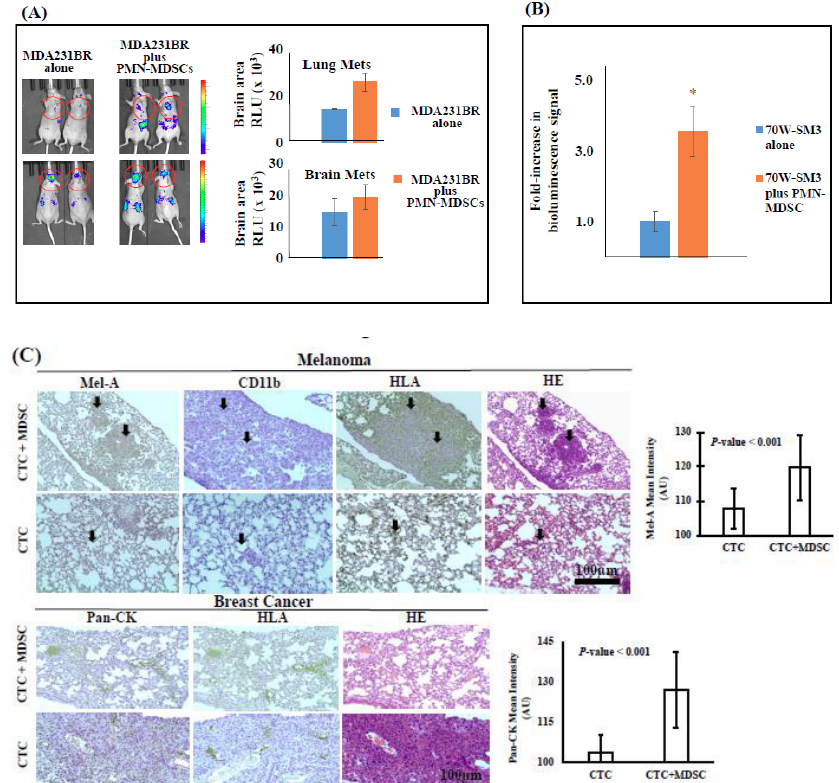
Figure 4. The detection of bioluminescence signal following the injection of human brain-metastatic breast cancer (MDA-MB-231BR) ( A ) (red circles refer to the detection of brain metastasis in mice) or melanoma (70W-SM3) mice ( B ) cells with or without co-transplantation with circulatory PMN-MDSCs isolated from blood of respective patients. Representative animals are shown ( n = 3/subgroup; * p < 0.001). ( C ) CTC metastatic competence is increased by PMN-MDSCs. Patient-isolated CTCs were injected together with PMN-MDSCs derived from respective breast cancer or melanoma patient blood via intra-cardiac route. Following animal euthanization and tissue organ processing, tumor cells were detected in metastatic foci by histopathology staining using human tumor cell-specific markers as indicated. Animal lung tissues of four breast cancer or melanoma patients were analyzed following the injection of CTCs/PMN-MDSCs. Magnified images (100×) were captured and quantified by free-access Image J software using the reciprocal intensity (250- y ) method [22]. Controls consisted of the detection of human tumor cells in tissues of animals injected only with CTCs. Tissues of animals injected only with patients’ MDSCs stained negative for human tumor cell-specific biomarkers (data not shown).